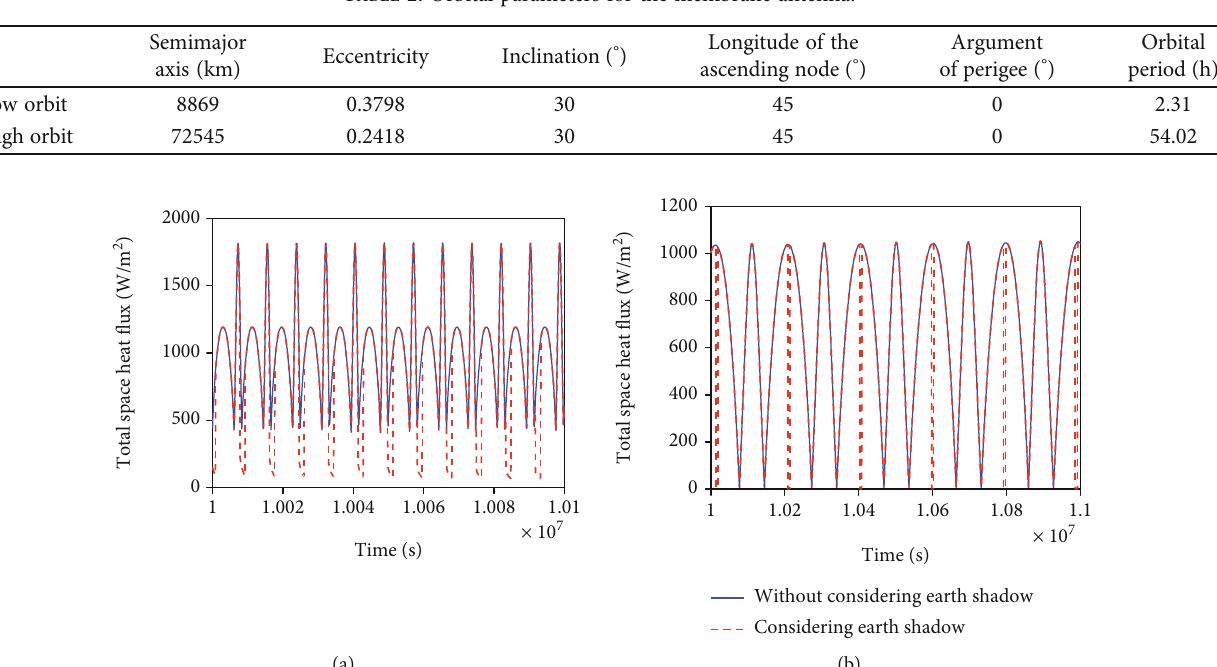
Table 2: Orbital parameters for the membrane antenna.